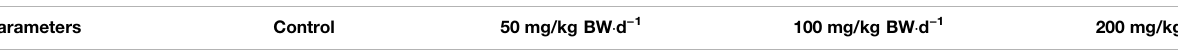
TABLE 4 | Effect of daily oral administration of jaranol on lipid pro fi le in mice.